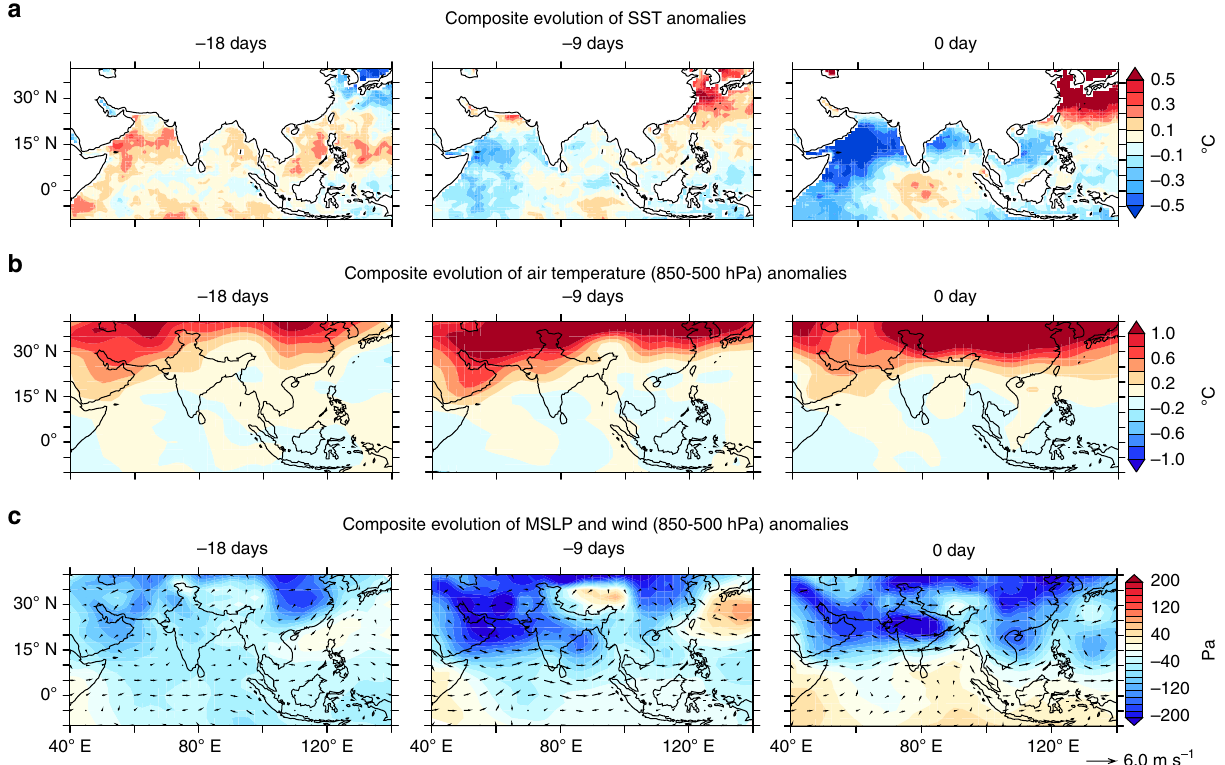
Fig. 5 Evolution of temperature, pressure and winds leading to widespread extreme precipitation events. Composite evolution of a sea surface temperature (SST) and b air temperature (850 – 500 hPa) anomalies (colors, °C), c mean sea level pressure (MSLP, colors, Pa) and wind (vectors, m s − 1 ), leading to widespread extreme precipitation events over central India (on 0-day). Daily data from OISST and NCEP reanalysis, for the period 1982 – 2015 is used for the composite analysis